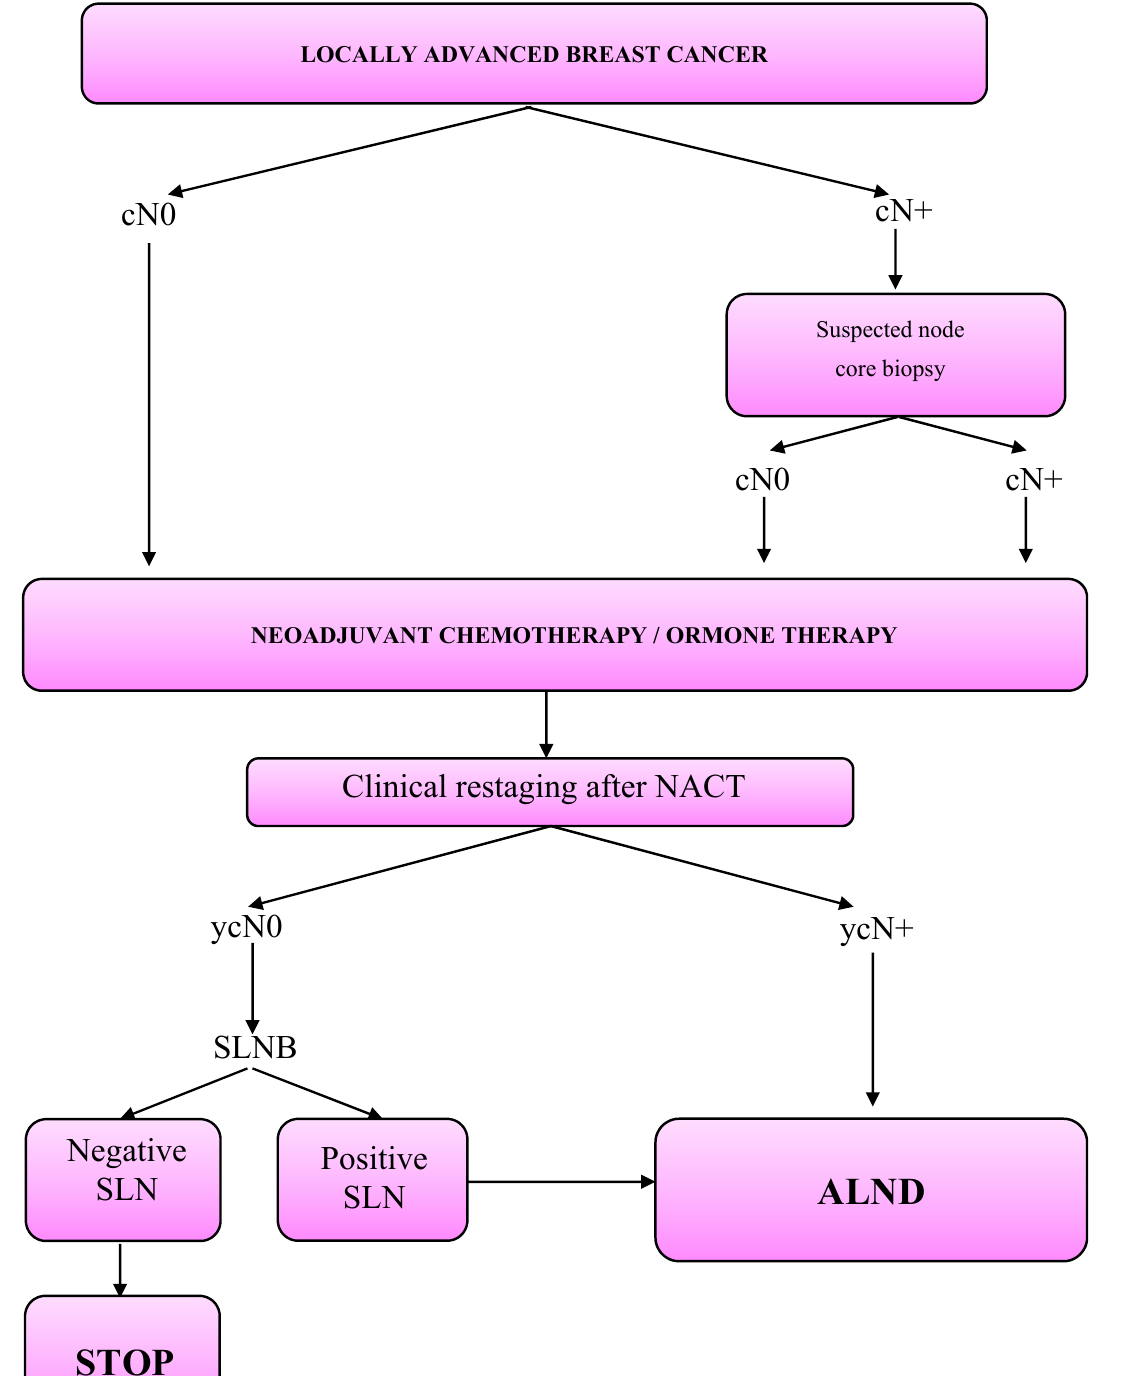
Figure 1. Axillary workout in the neoadjuvant setting. SLNB was performed using blue dye technique (Patent Blue V or Methylene blue, 2–5 cc) injected sub-dermally, 15–30 min before surgery. Blue-stained axillary lymph nodes were defined as SLNs. Axillary lymph nodes whose consistency and dimension were considered suspicious were also removed and analyzed. Pathologic examination of the SLN was macroscopic, cytologic and